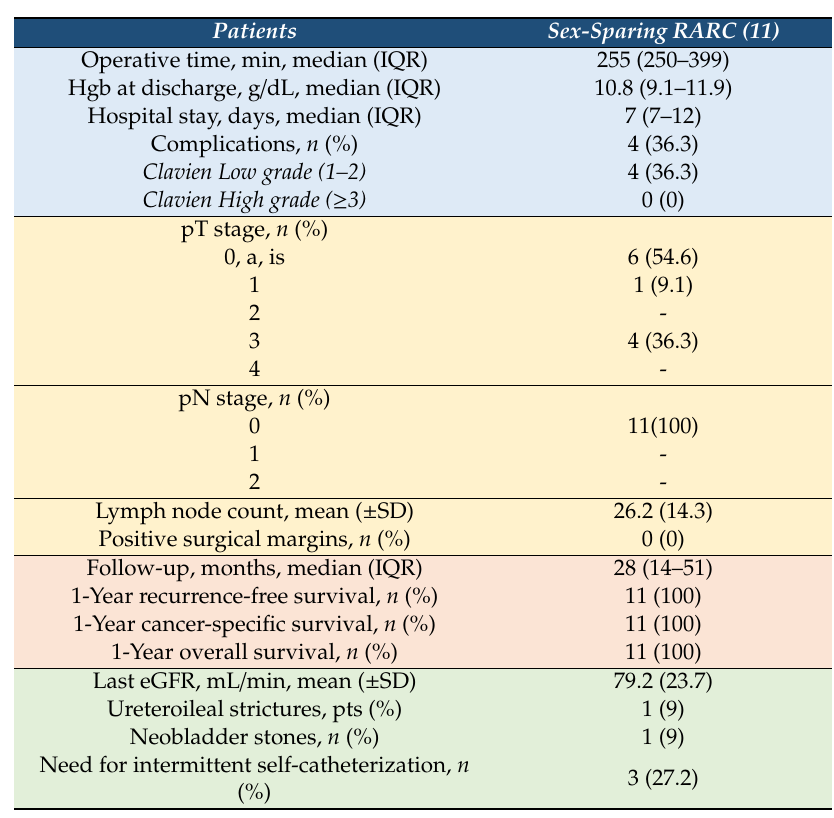
Table 2. Perioperative, pathologic, oncologic and functional